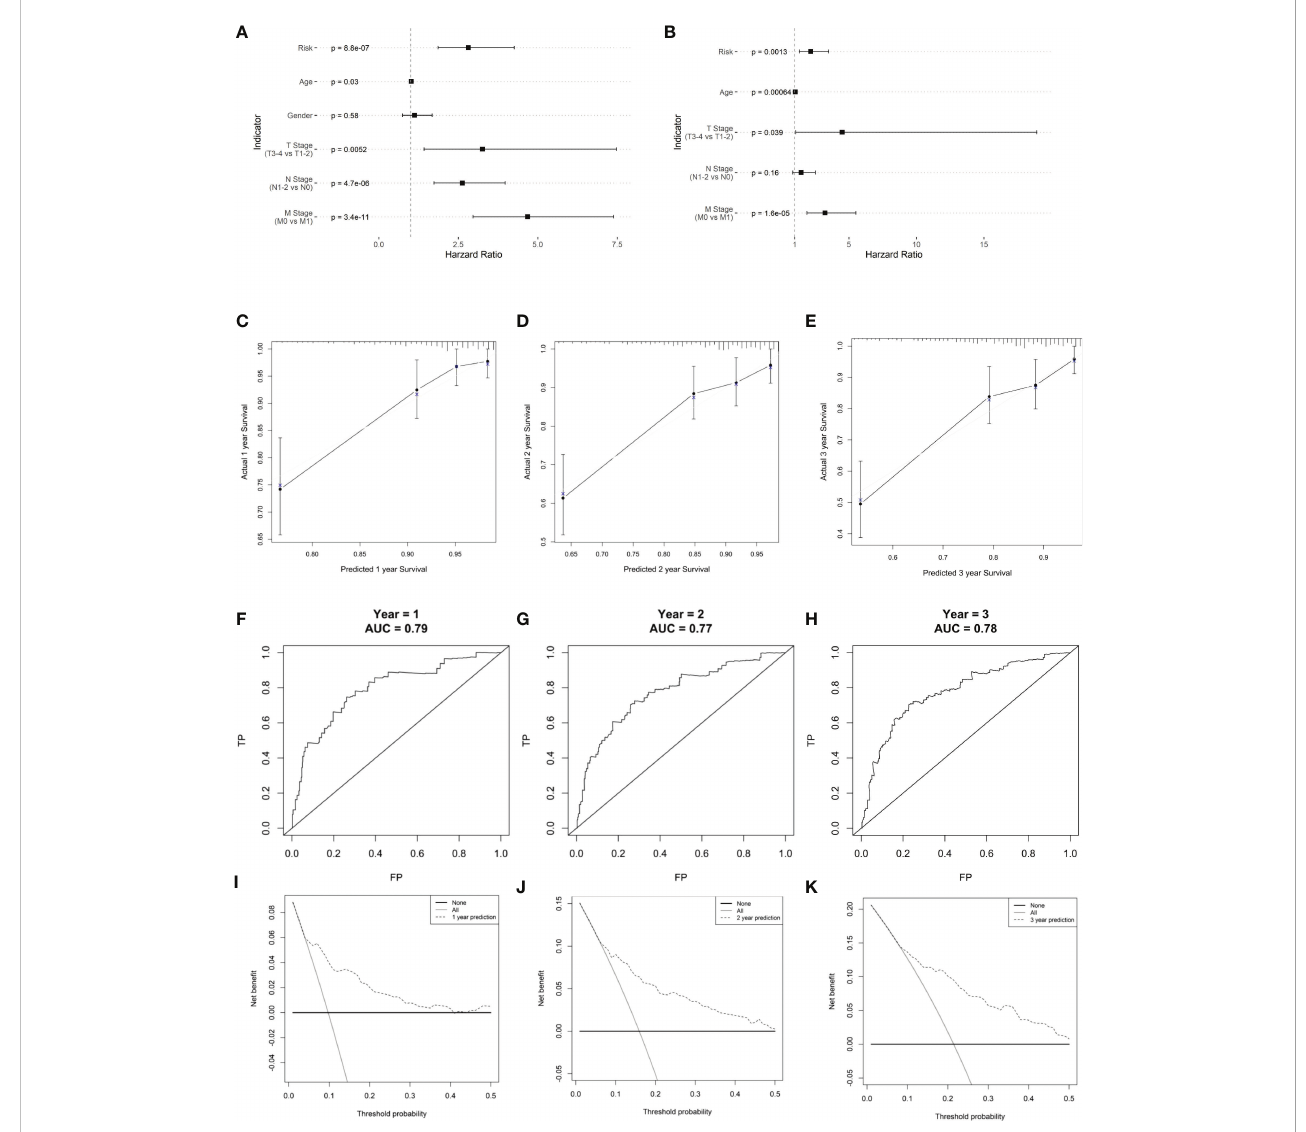
FIGURE 9 Clinical prognostic model construction. (A) Prognosis-related clinical indicators. (B) Forest plot of multifactorial Cox model. (C – E) 1-, 2-, and 3-year survival calibration curves, respectively. (F – H) Calibration curves for 1-, 2-, and 3-year survival rates, respectively. (I – K) ROC curves for 1-, 2-, and 3-year survival rates,